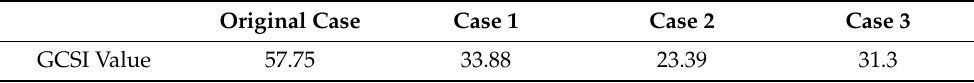
Table 7. Generator capacity selection index (GCSI) value of each